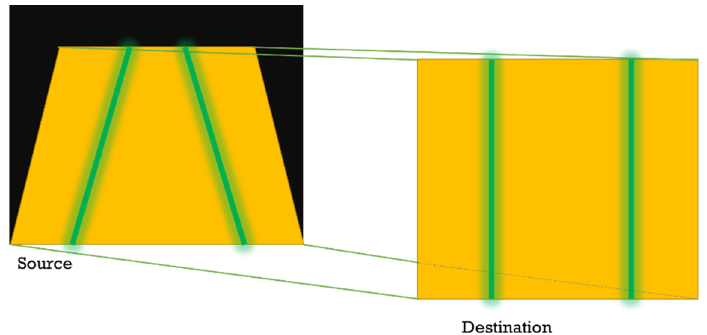
Figure 3. The perspective transformation of the depth maps. The rows are transformed using the equations in Table 1 to generate a map that shows the rows to approximately straight rows that would allow an algorithm to detect the rows easily. Table 1. The perspective transformation vertices for depth maps. Part of the source image vertices are chosen, and then transformed into another image (destination) that can easily show the rows in straight patterns, which can easily let the model detect the shape of the rows. The width of the image